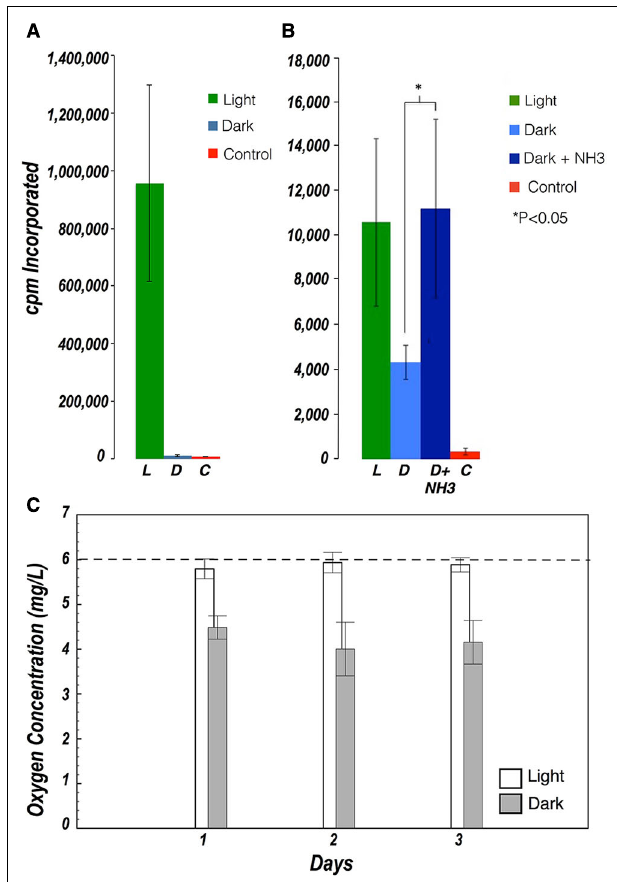
FIGURE 3 | (A) Carbon fixation in halite cell suspensions in the presence of light (green) and in the dark (blue) (B) Carbon fixation in ground halite in the presence of light (green), in the dark (light blue), and in the dark after addition of NH 3 as an electron donor (dark blue). Controls with no viable cells are shown in red. Dark Carbon uptake was only observed in ground samples (not in cell suspensions) and was stimulated after addition of NH 3 . Values represent the average of 3–5 measurements. Error bars represent standard deviations. (C) Evolution of oxygen concentration in cell suspensions exposed to light (white) and dark (gray). The dashed line shows the oxygen concentration measured at the beginning of the